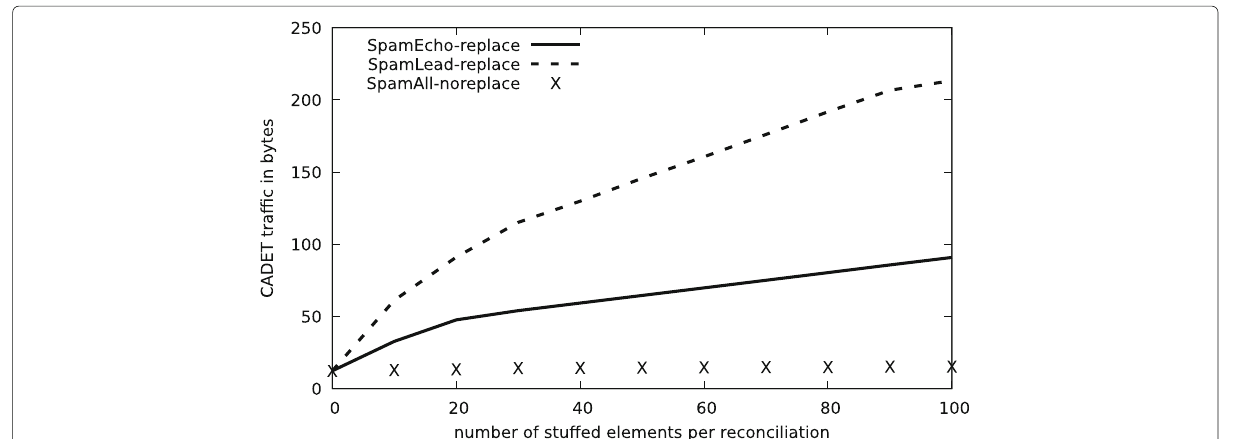
Fig. 9 CADET traffic for BSC on 100 elements of 64 bytes and one malicious peer with the indicated mode. Average over 50